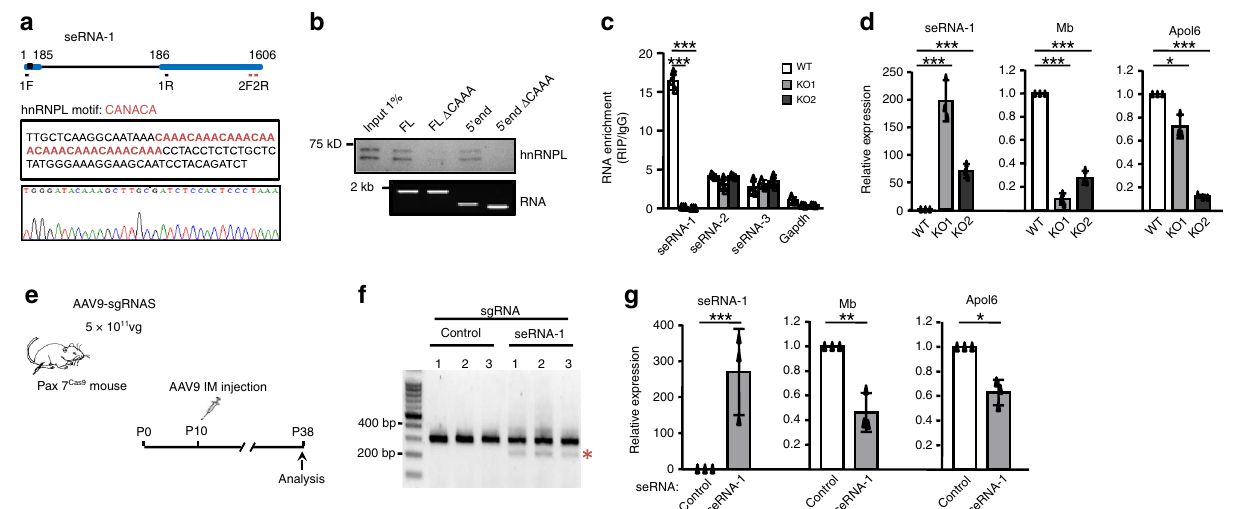
Fig. 5 CAAA tract is indispensable for seRNA-1 function. a Schematic illustration of CAAA deletion medicated by CRISPR-Cas9 editing in C2C12 cells. Top: black box depicts the deletion region. Primer set 1 (1F and 1R) was used for cDNA genotyping. Primer set 2 (2F and 2R) was used for qRT-PCR analysis. Middle: CAAA tract sequence is highlighted in red. sgRNAs were designed to delete the underlined sequence encompassing the CAAA tract. Bottom: Result from Sanger sequencing con fi rmed the CAAA deletion. b Biotinylated seRNA-1 transcripts of full length (FL) or 5 ′ end fragment with or without CAAA deletion ( Δ CAAA) were used in RNA pull-down assay to reveal seRNA-1 binds hnRNPL through the CAAA tract embedded in its 5 ′ region. c hnRNPL RIP was performed in WT or the generated CAAA deletion (KO) cells to show hnRNPL/seRNA-1 binding was abolished in the KO cells as compared to WT control cells. Enrichment was determined as RNA associated to hnRNPL IP relative to IgG control. d Expression of the associated target genes, Mb and Apol6, was decreased but seRNA-1 was increased in the KO cells as measured by qRT-PCR. e Schematic illustration of the CRISPR-Cas9 mediated in vivo deletion of CAAA tract. Pax7 Cas9 mouse at postnatal 10 (P10) age was intramuscularly (IM) injected with 5 × 10 11 vg AAV9-sgRNAs viruses and the infected muscles were recovered for analysis at 4 weeks later (P38). n = 3 per group. f Detection of CAAA excision by genomic PCR in muscle tissues injected with AAV9-sg-seRNA-1, compared to AAV-sg-Control. Un-edited product, 304 bp; deletion product (red asterisk), 220 bp. g qRT- PCR was performed to measure the levels of seRNA-1, Mb and Apol6 in the above injected muscles. n = 3 per group. Data represent the average of three independent experiments ± s.d. Statistical analysis was done by two-tailed unpaired Student ’ s t -test ( c, d, g ), * P < 0.05, ** P < 0.01, and *** P < 0.001. Source data are provided as a Source Data fi